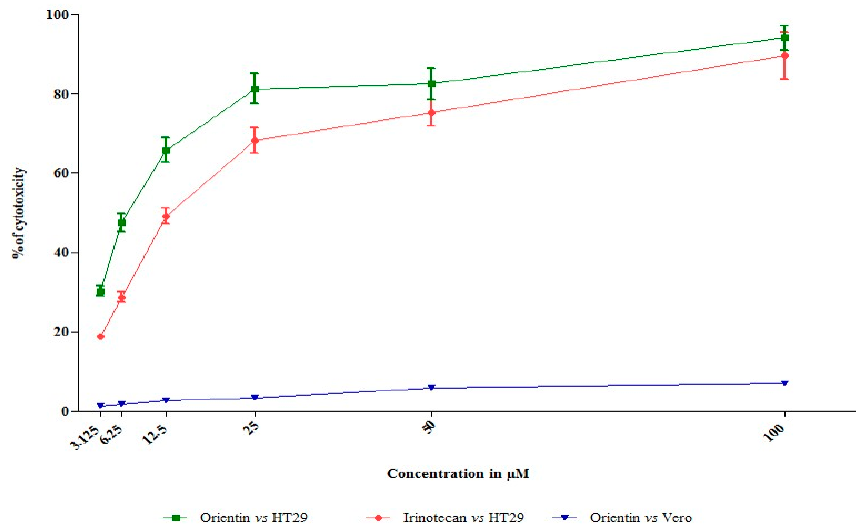
Figure 1. Effect of orientin on colorectal carcinoma and normal epithelial cell viability. Change in HT29 and normal epithelial cell viability with treatment of different concentrations of orientin and irinotecan were observed. The results were represented as mean ± SD of three independent parallel measurements.